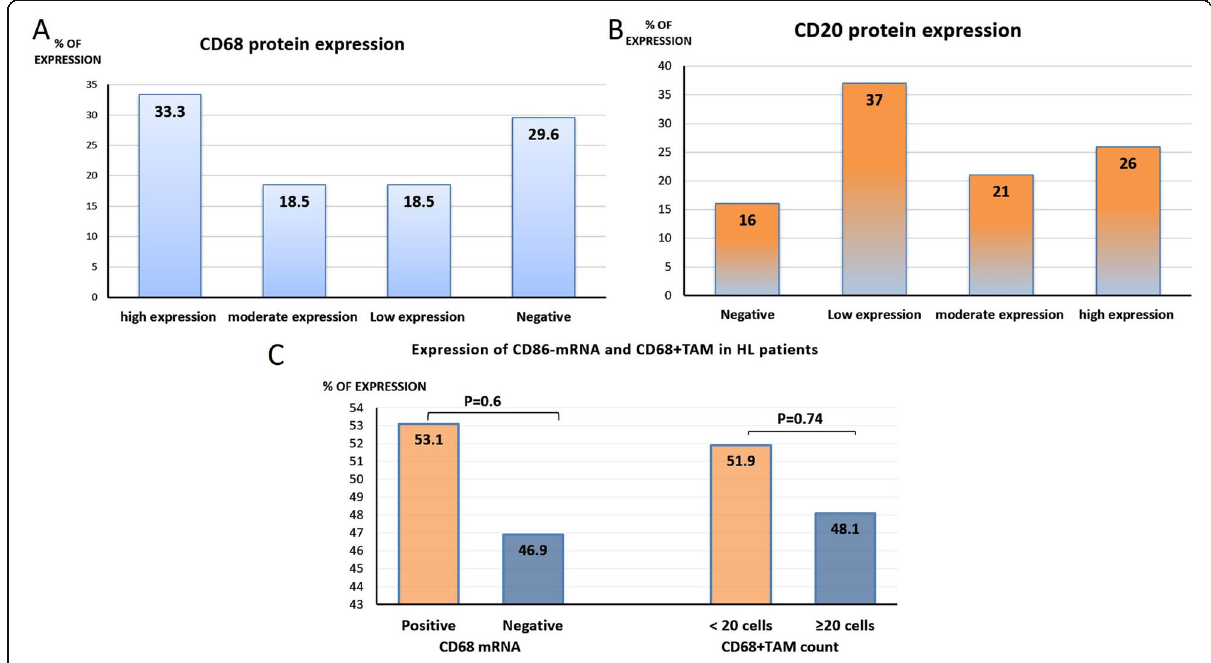
Fig. 1 the expression levels of a ) CD68 proteins by IHC, b ) CD20 proteins by IHC, c ) CD68 by FCM and